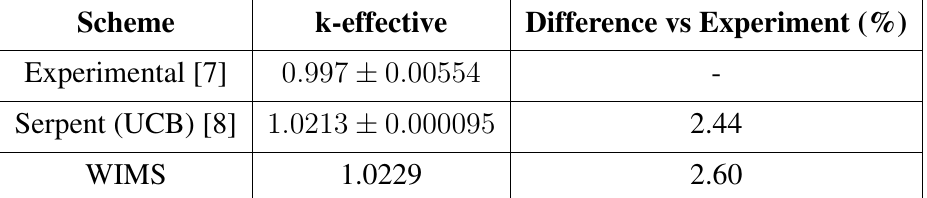
Table I: Benchmark modelling